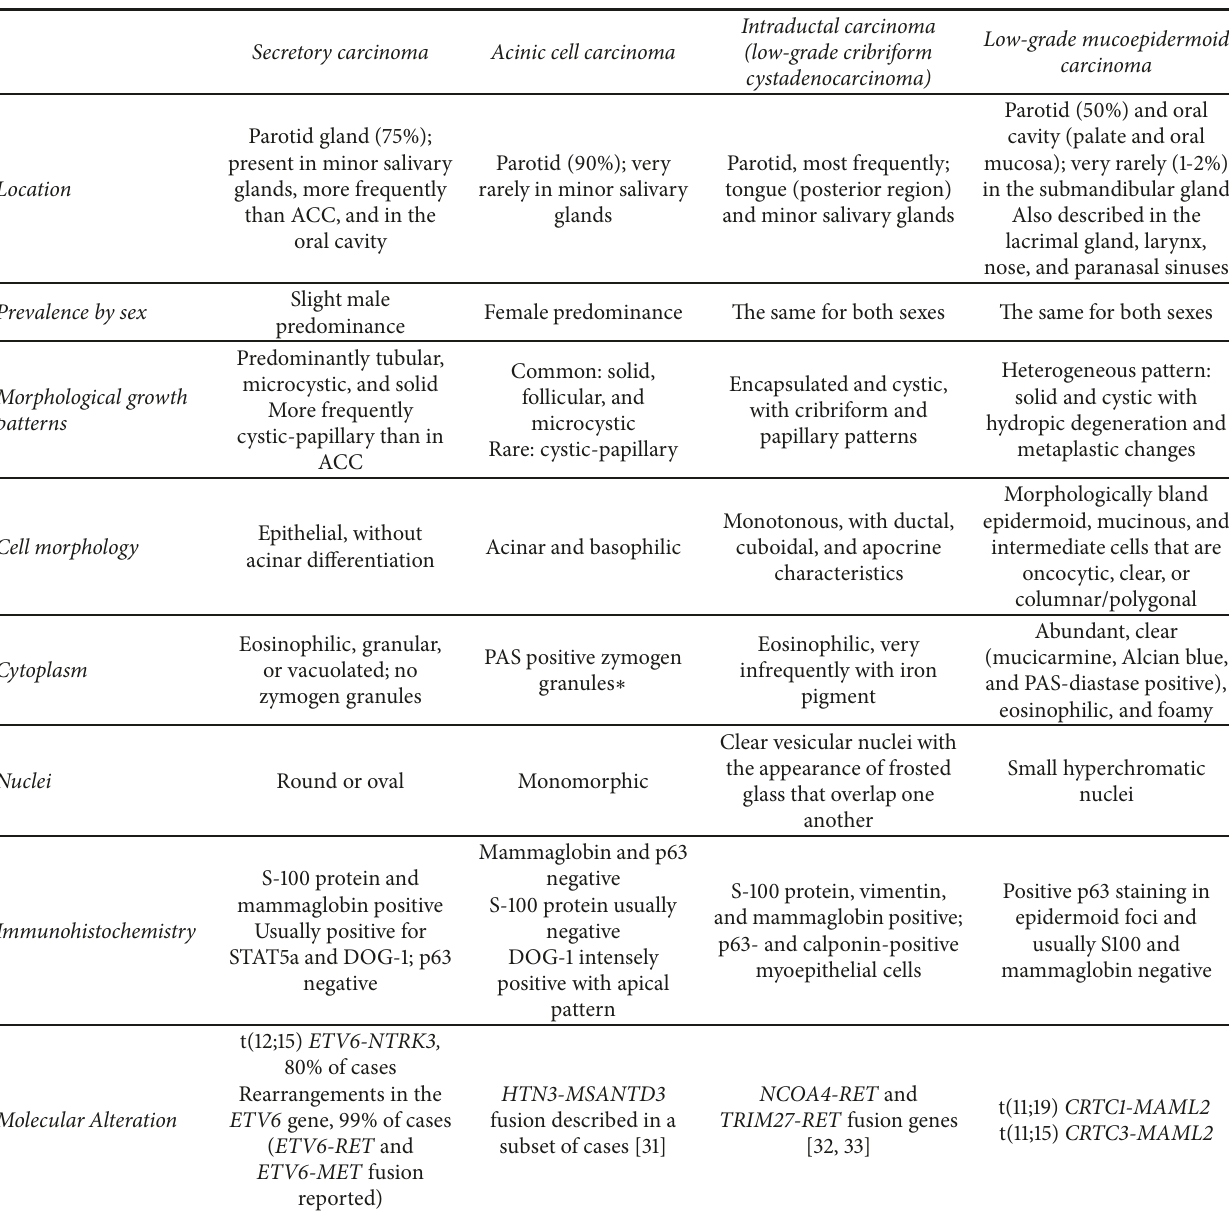
Table 2: Key elements in the differential diagnosis of secretory